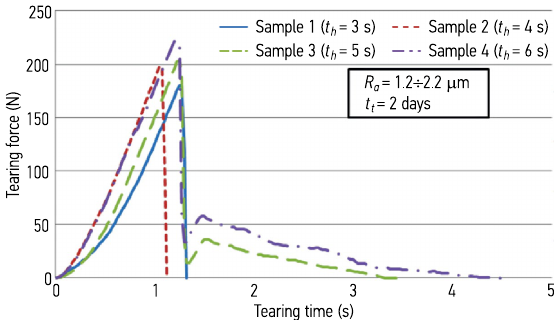
Fig. 5. Characteristic tearing forces in the function of time